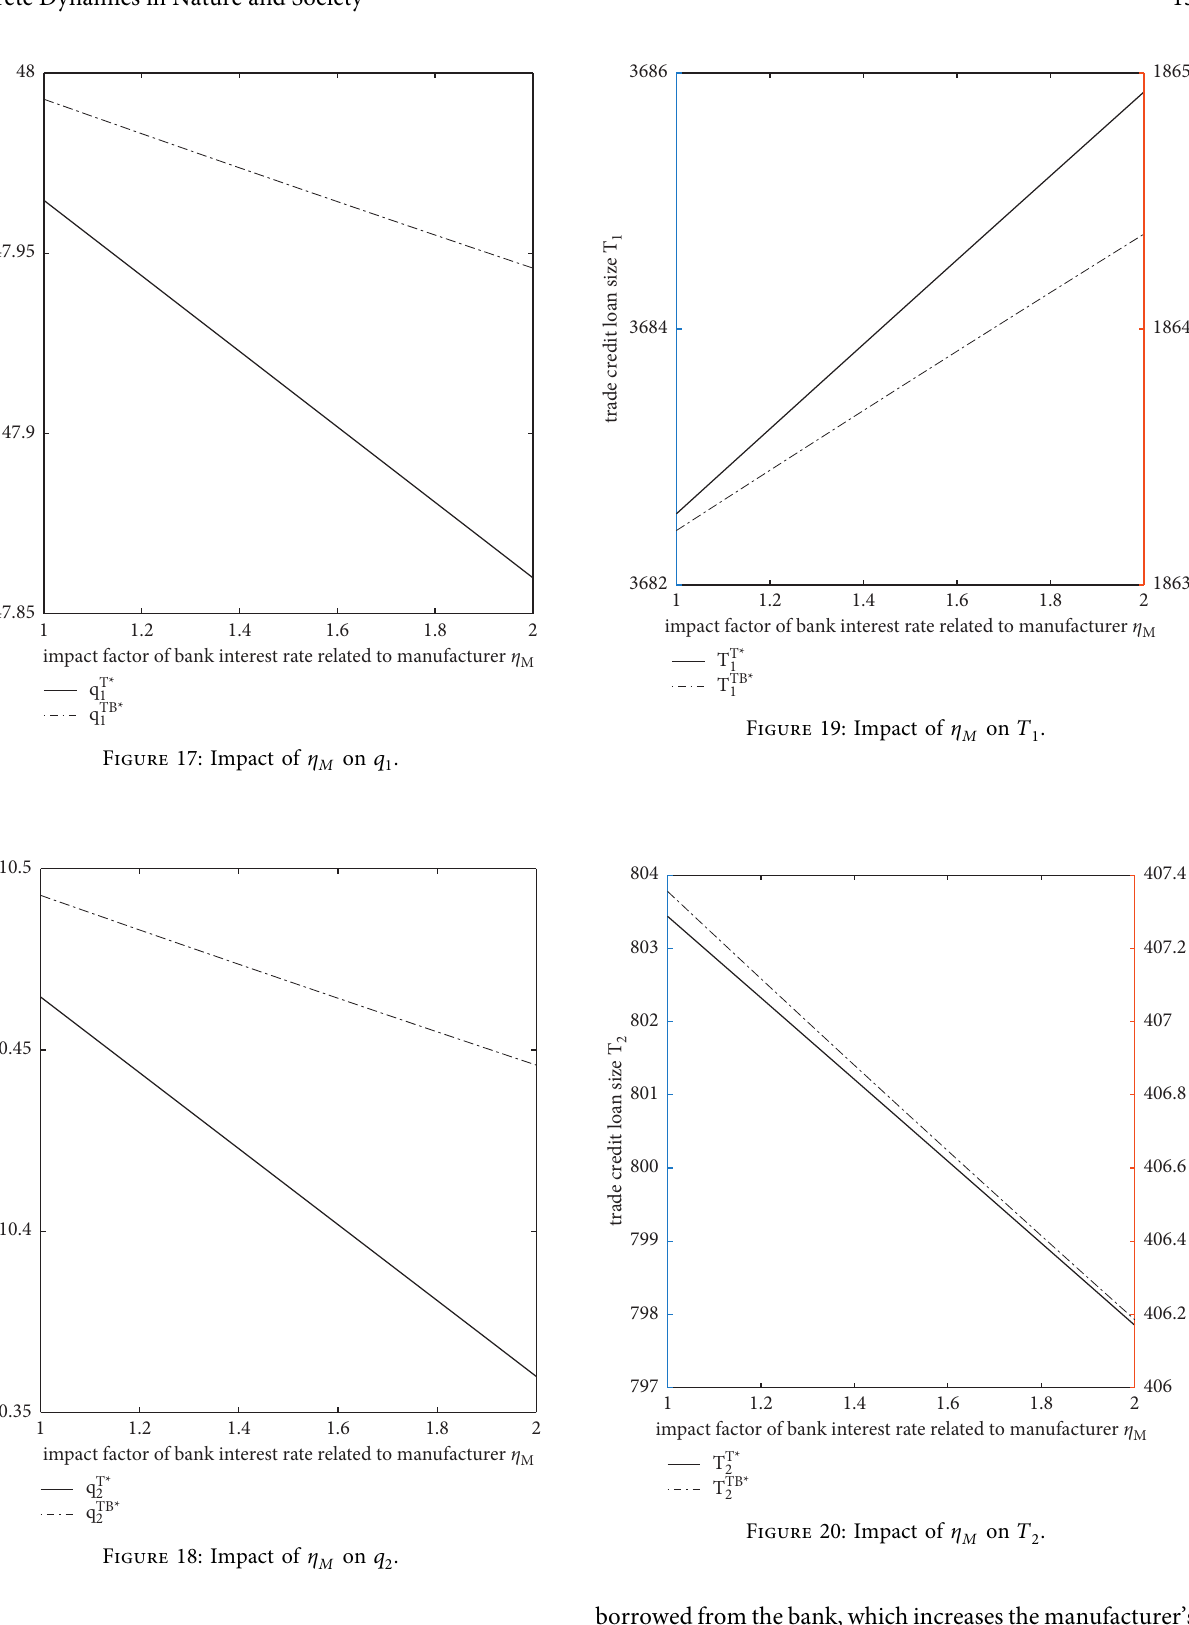
Figure 18: Impact of η